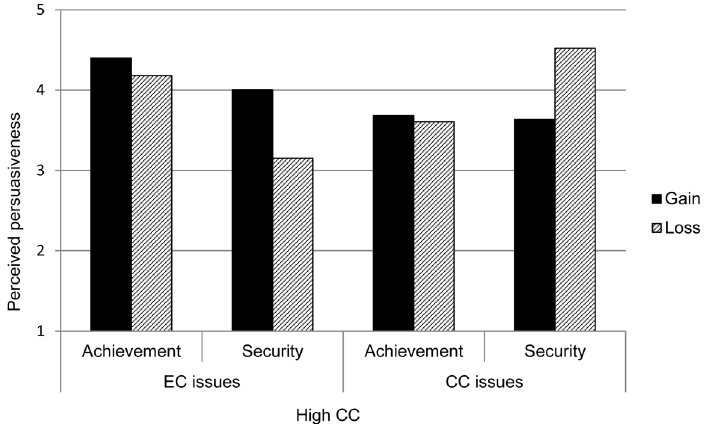
Figure 4b. Perceived persuasiveness as a function of type of issue, type of benefit and outcome focus under high cultural conservatism (Study